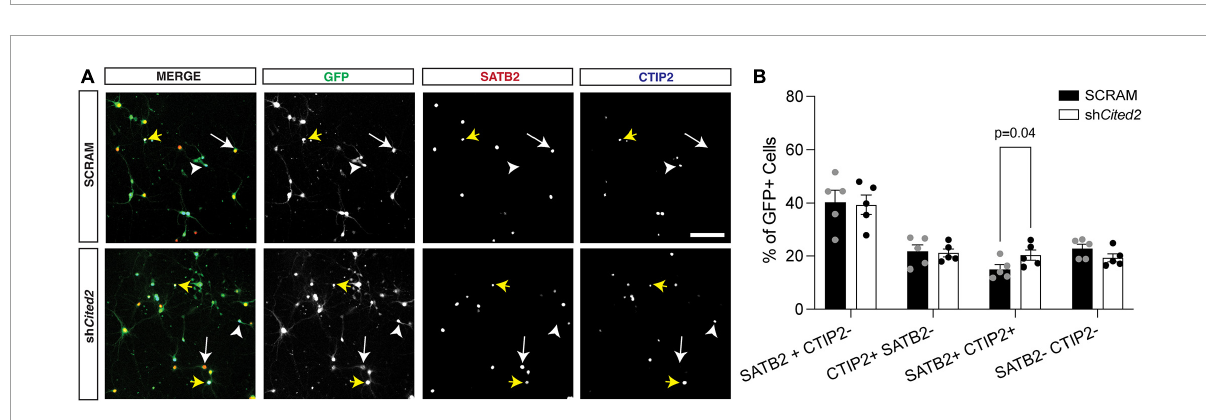
FIGURE3 shRNA-mediated Cited2 knockdown leads to an increase in neurons that co-express SATB2 and CTIP2 in vitro . (A) Representative micrographs of 7 DIV primary neuronal cultures electroporated with a control SCRAM or sh Cited2. Arrows indicate SATB2 + CTIP2- neurons (white arrow), CTIP2 + SATB2- neurons (white arrow head), and SATB2 + CTIP2 + co-expressing neurons (yellow arrows). (B) Quantification of transfected cells shows an increased percentage of SATB2 + CTIP2 + co-expressing neurons in sh Cited2 vs SCRAM. N = 5. Two-way ANOVA with Šídák’s multiple comparisons test. Error bars denote SEM. Scale bar, 100 µ